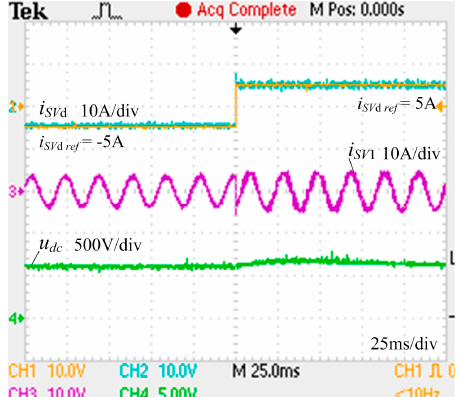
Figure 13. DC-bus voltage and phase current experimental result. CH1: i SVdref , 10 A/div; CH2: i SVd , 10 A/div; CH3: i SV 1 , 10 A/div; CH4: u dc , 500 V/div; 25 ms/div. Table 7. Operation conditions of Figures 12 and 13.